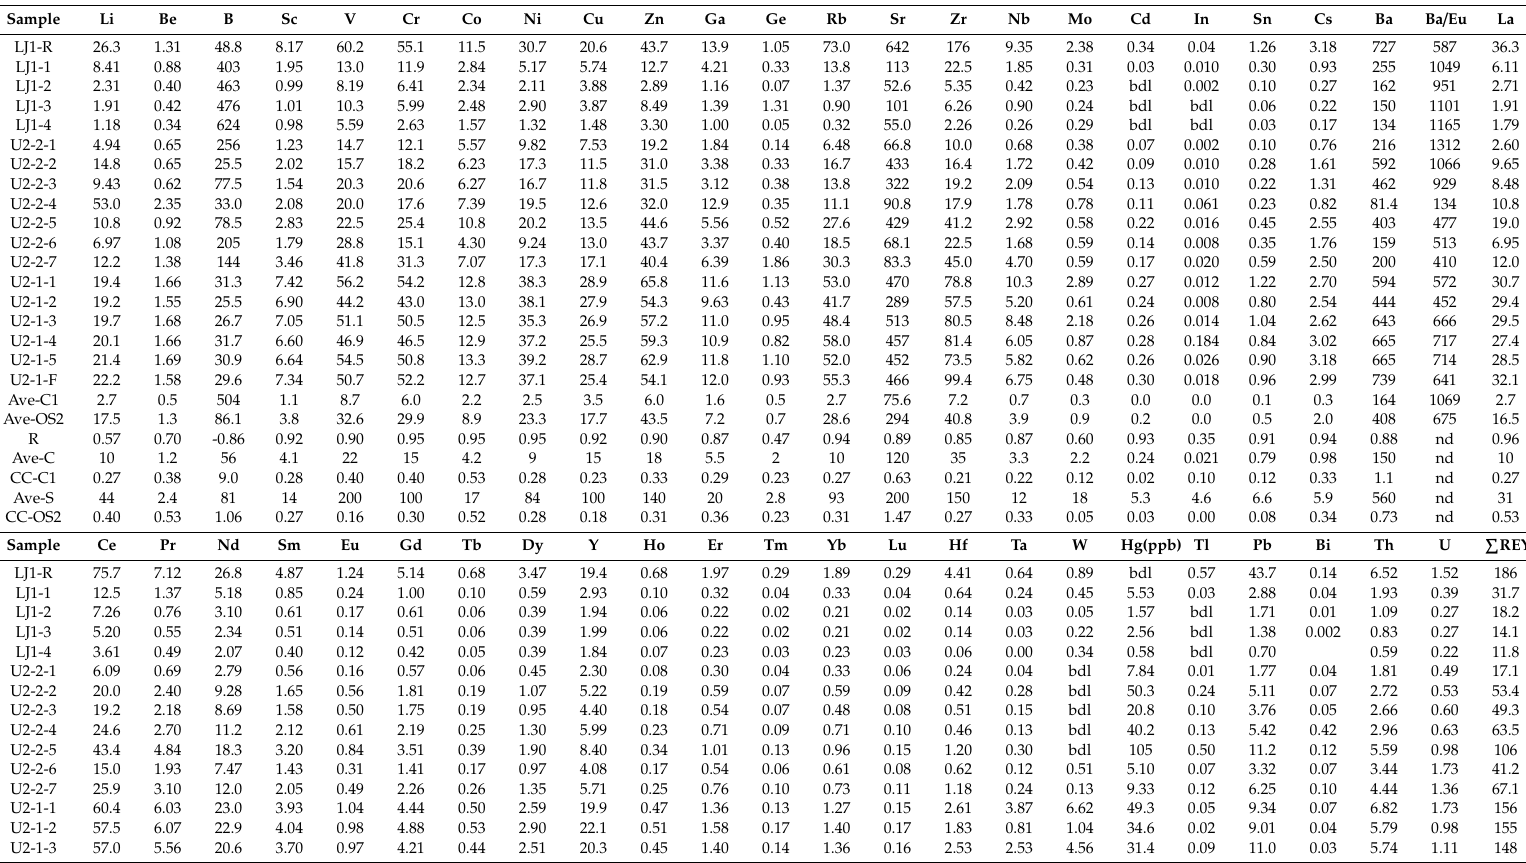
Table 3. Concentrations of trace elements (ppm) in the Liangjia C1 coals, OS2 oil shales, the roof and floor samples (whole-rock basis).